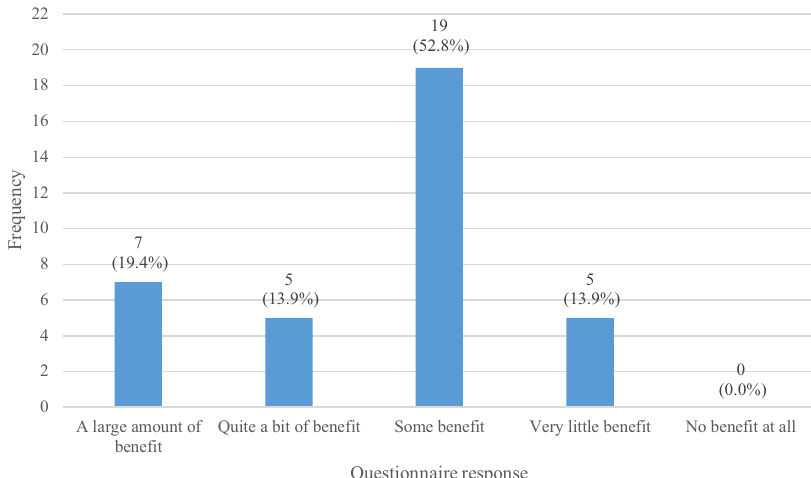
Fig. 1 Bene fi ts of My Breathing Matters. Participant responses to single item on My Breathing Matters Satisfaction Questionnaire relating to bene fi ts of using My Breathing